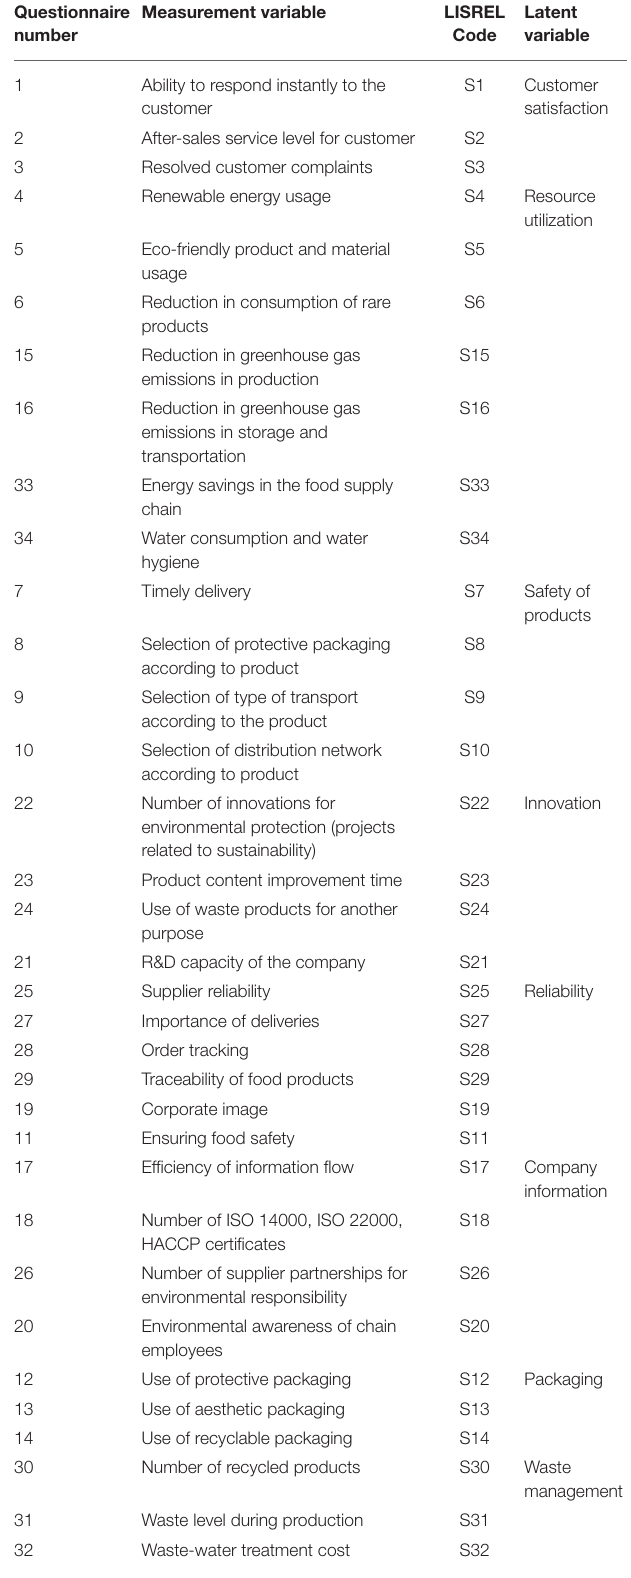
TABLE 3 | Measurement variables and LISREL codes according to latent